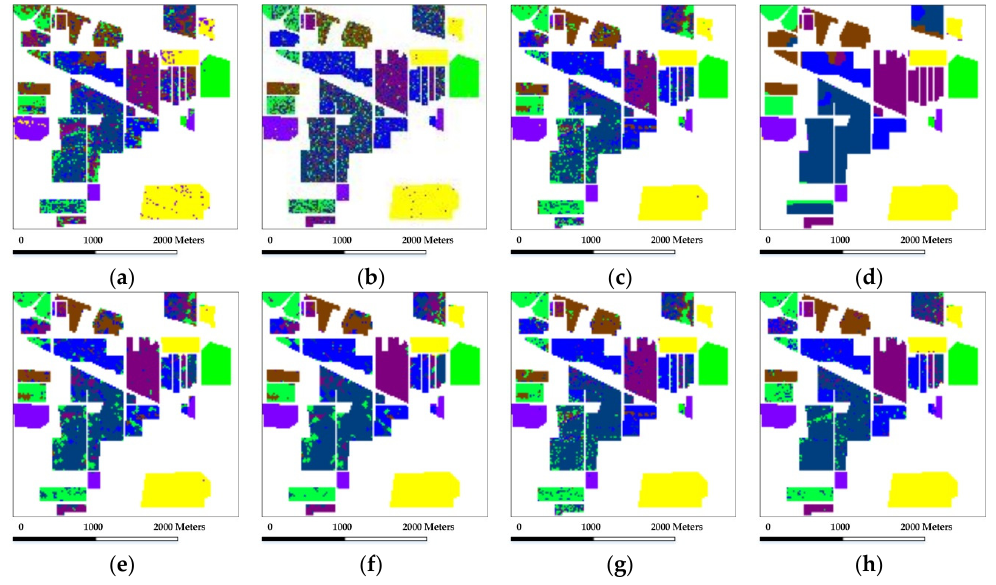
Figure 4. Classification maps obtained by the different tested method for the AVIRIS Indian Pines scene (OA are in parentheses): ( a ) SVM(63.57%); ( b ) CRC (70.89%); ( c ) SRC (78.18%); ( d ) SVM-MRF (84.31%); ( e ) JSRC (81.47%); ( f ) GSRC (86.84%); ( g ) NL-SRC (85.04%); ( h ) NSLS-GSRC (90.54%). Table 1. Classification accuracies (in percent) obtained by the different tested methods for the AVIRIS Indian Pines scene. In all cases, 400 labeled samples in total (50 samples per class) were used for training. The best results are in bold.